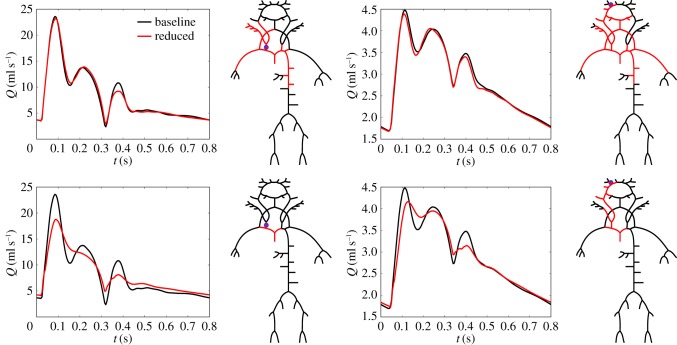
Optimal reduced networks for flow at the distal end of the right carotid artery (left panel) and proximal end of the right middle cerebral artery (right panel). The networks are the same as shown in figure 6; however, parameters were altered in order to represent normal ageing as described in §2.6.